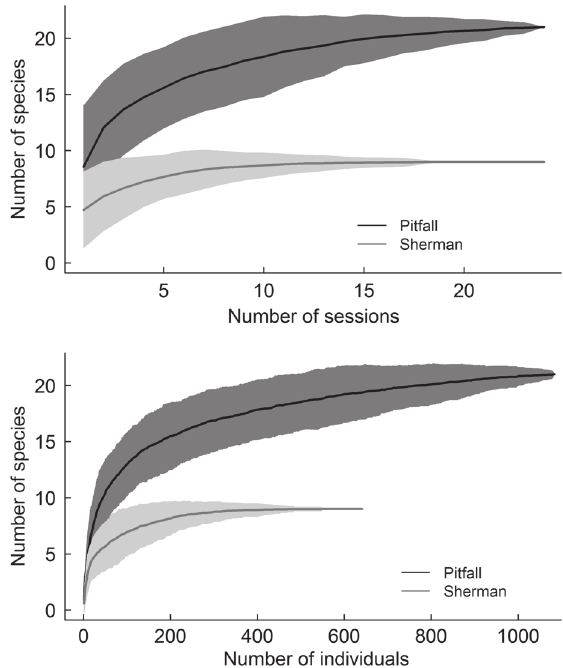
Figure 3. Mean accumulation curves of the number of species (mean and standard deviation) as a function of sampling effort (either the number of capture sessions or the number of captured individuals) for pitfall and Sherman traps at the Morro Grande Forest Reserve.